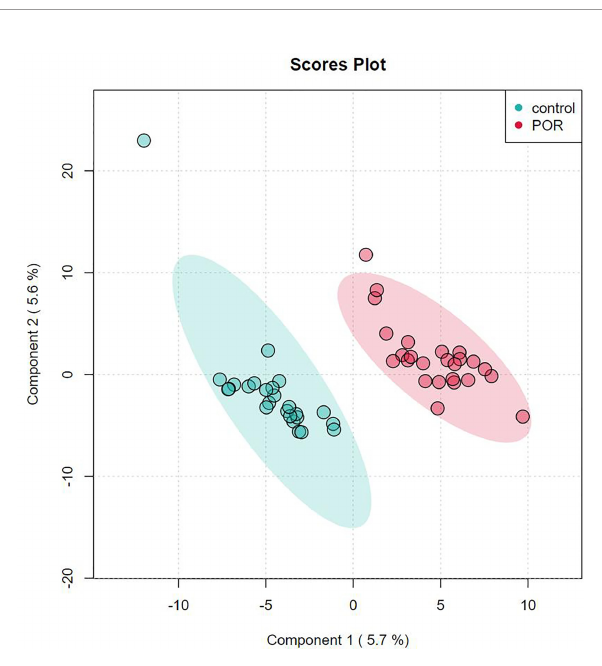
FIGURE 4 | Score plot analysis of PLS-DA of group of POR and controls. Each point corresponds to a sample, and the abscissa and ordinate are the values of the two factors with the best discrimination effect. Different groups are marked with different colors, and the area marked by ellipse is the 95% con fi dence area of sample points.